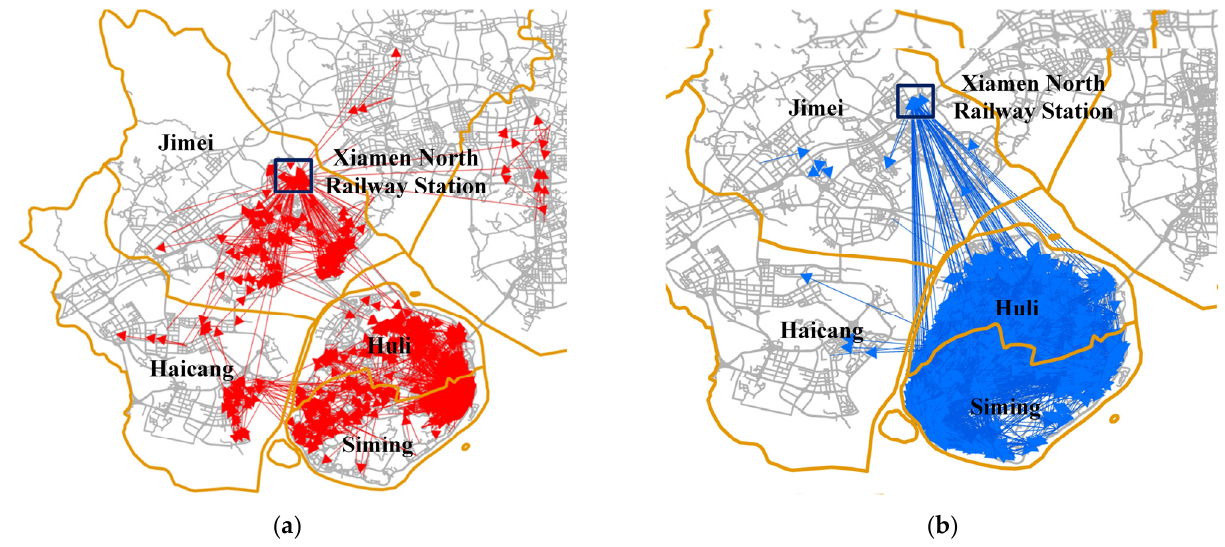
Figure 10. Results of local Geographically Weighted Flow Cross K-Function at the scale of 800 m: